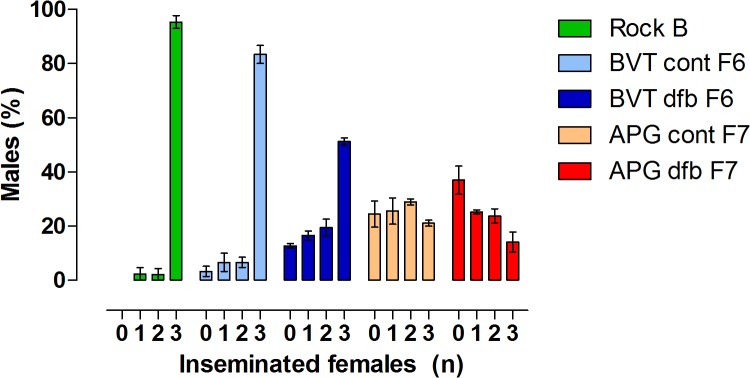
Male mating efficiency for Rockefeller (Rock), and selected (dfb) or control (cont) groups of Boa Vista (BVT) and Aparecida de Goiânia (APG) mosquitoes.For each group, one male was placed in contact with three females for three days. The results are expressed as the percentage of males able to inseminate one, two or three females.